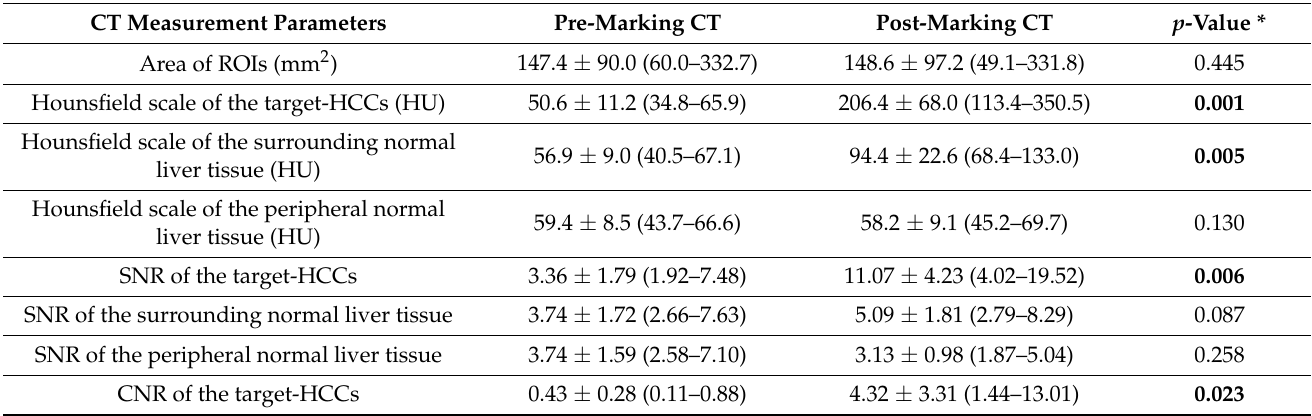
Table 2. The quantitative analysis of the visualization of